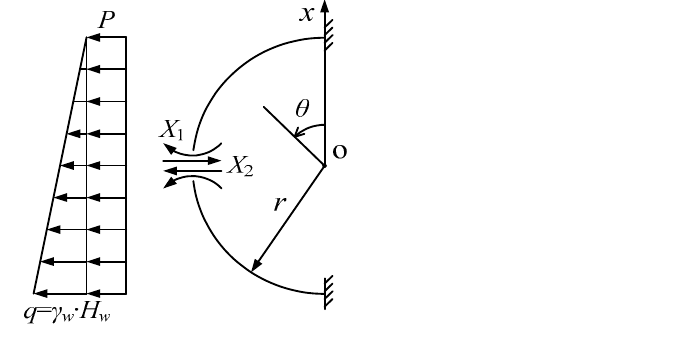
Figure 2. Basic system for internal force calculation of pressurized water conveyance tunnel.